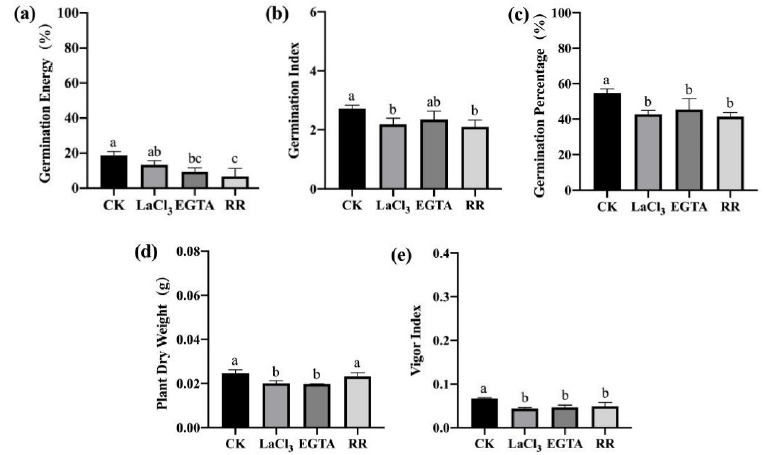
Figure 8. Ca 2+ chelating agent/channel inhibitor treatments inhibited seed germination and seedling growth of low-vigor maize seeds. ( a ) germination energy (%), ( b ) germination index, ( c ) germination percentage (%), ( d ) dry weight of single plant (g), ( e ) vigor index. EGTA, ethylene glycol-bis(beta-aminoethyl ether)-N-tetraacetic acid; RR, Ruthenium Red; CK, control. Different letters indicate significant differences among different lines (Tukey’s test).